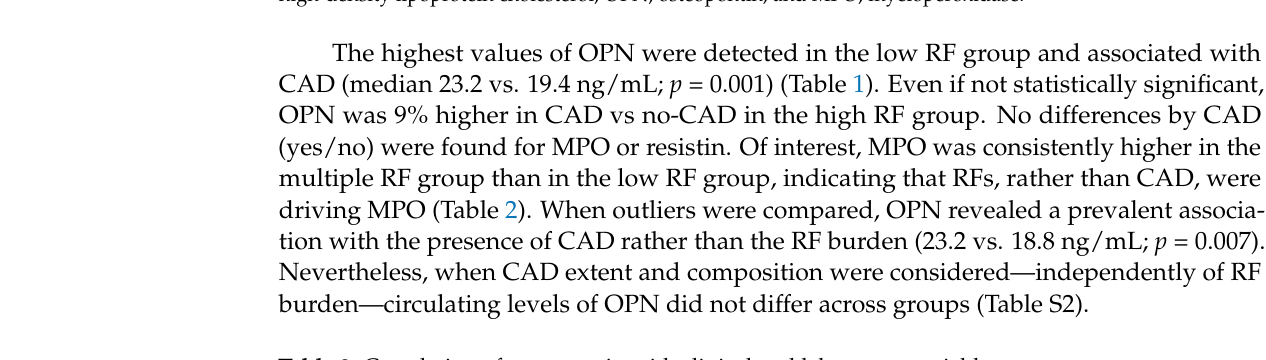
Table 2. Correlation of osteopontin with clinical and laboratory